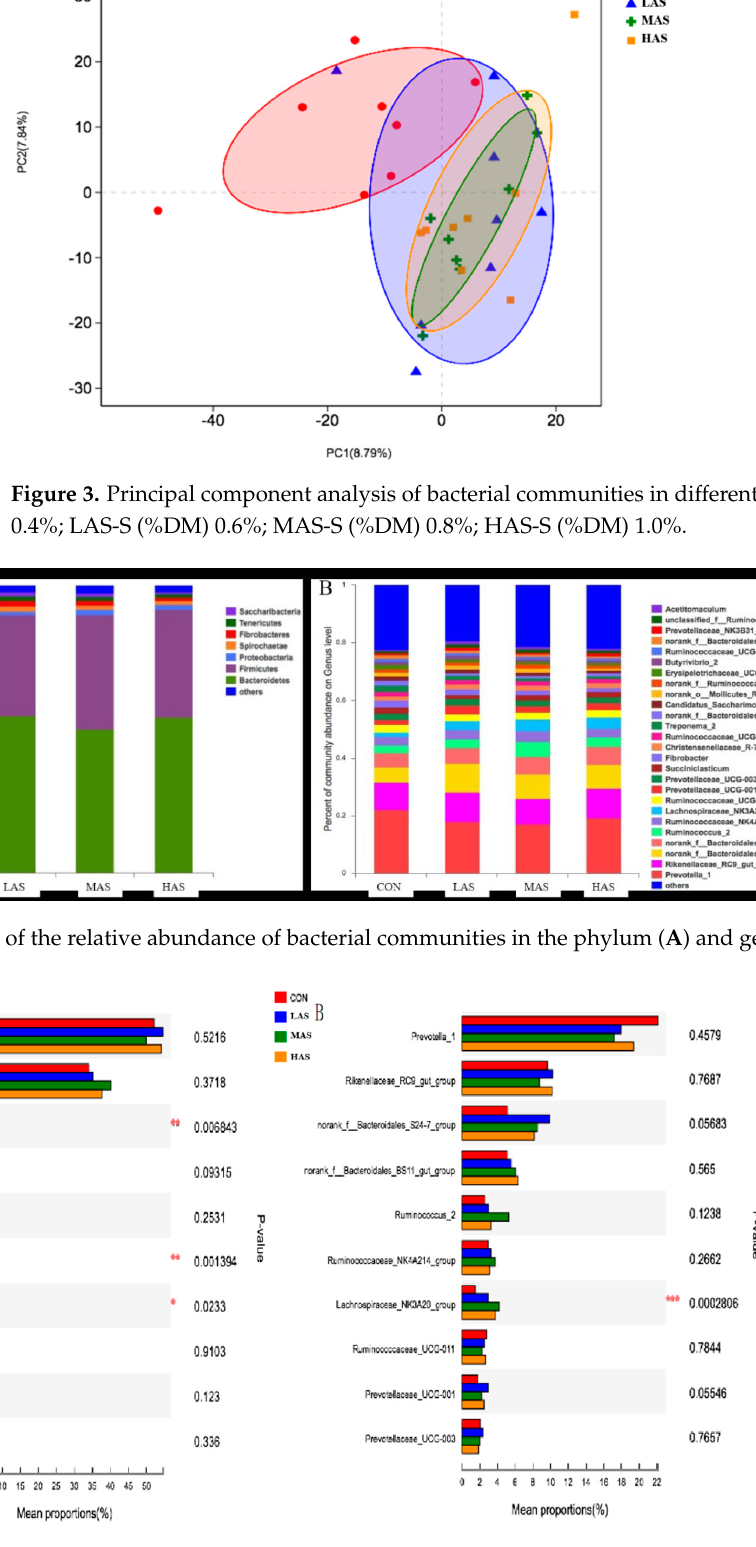
Figure 6. Present of Desulfovibrio in rumen samples. CON-S (%DM) 0.4%; LAS-S (%DM) 0.6%; MAS- S (%DM) 0.8%; HAS-S (%DM) 1.0%. Asterisks mean significant difference between CON and HAS groups. 3.3. Effect of High Sulfur Diet on Rumen Epithelial Barrier Function Figure 7 shows different cell layers of rumen epithelium observed under a 4 × 10-fold light microscope. Image-Pro Plus 6.0 image analysis software was used to measure the thickness of different cell layers in the rumen epithelium. The difference between the ru- men epithelium length in the four additional sulfur levels was noted (Table 6). The length of papillae in the rumen epithelium increased significantly with the increase in sulfur con- tent ( p < 0.01). The total epithelial thickness of the rumen epithelium in the HAS group was significantly higher than that of the other groups, and it gradually increased with the